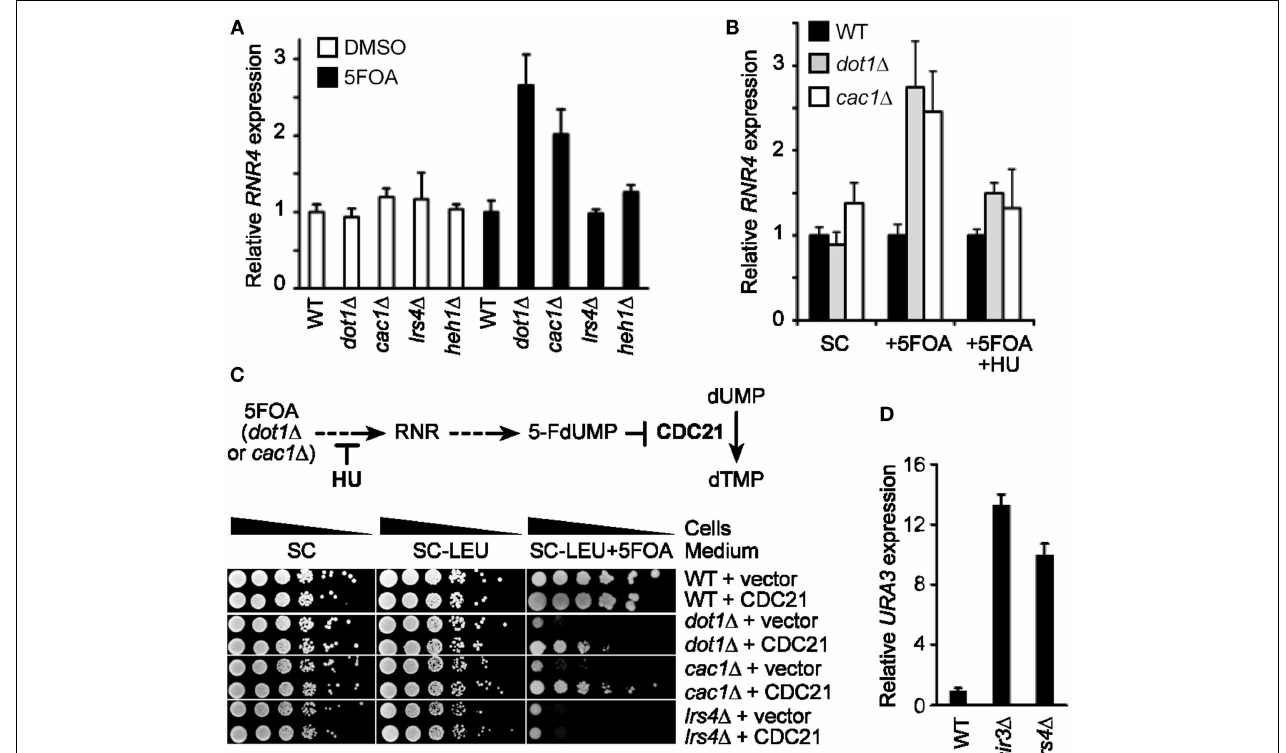
FIGURE 3 | FOA-treatment increases RNR expression in dot1 ∆ and cac1 ∆ cells, but not lrs4 ∆ cells, and CDC21 overexpression or HU treatment restores 5FOA resistance to dot1 ∆ and cac1 ∆ cells, but not lrs4 ∆ cells. (A) RNR4 transcript levels (normalized to ACT1 ) as measured by quantitative reverse transcriptase PCR (qRT-PCR) following a 4-h treatment with 5FOA or DMSO. Error bars represent the SEM for three independent experiments.WT, wild-type. Strains: KMY368, KMY1391, KMY1465, KMY74, KMY59. (B) Expression levels of RNR4 (normalized to ACT1 ) measured by qRT-PCR following a 4-h treatment with 5FOA with or without HU. Error bars represent the SEM for two